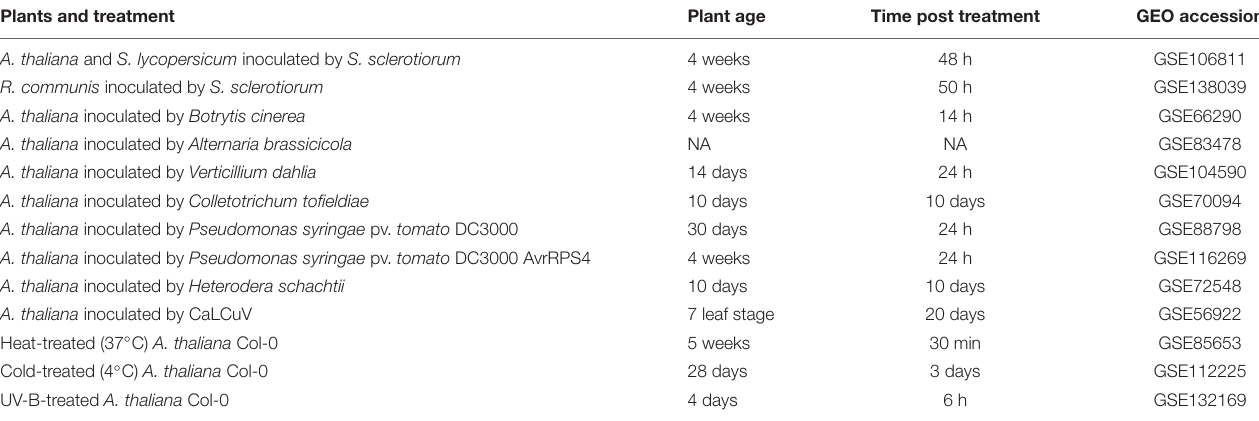
TABLE 1 | List of experiments used to analyze the response of A. thaliana PADRE to multiple biotic and abiotic stresses, with the corresponding GEO accession numbers. Plants and treatment Plant